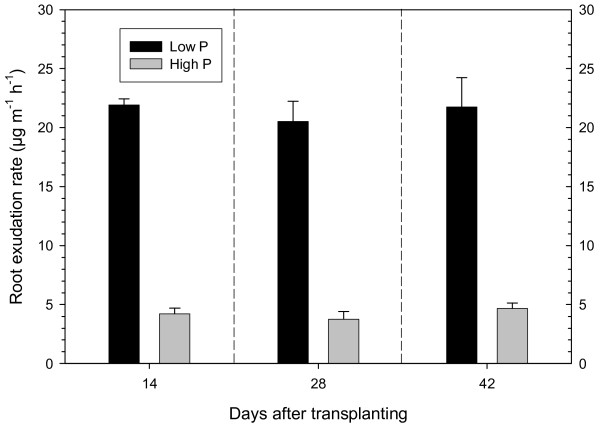
Root exudation rates. Rate of root exudation of sugar beet grown at low (2 μM) and high (500 μM) P is shown. Values originate from three harvest times and are given as means ± standard error of 3 replicates.